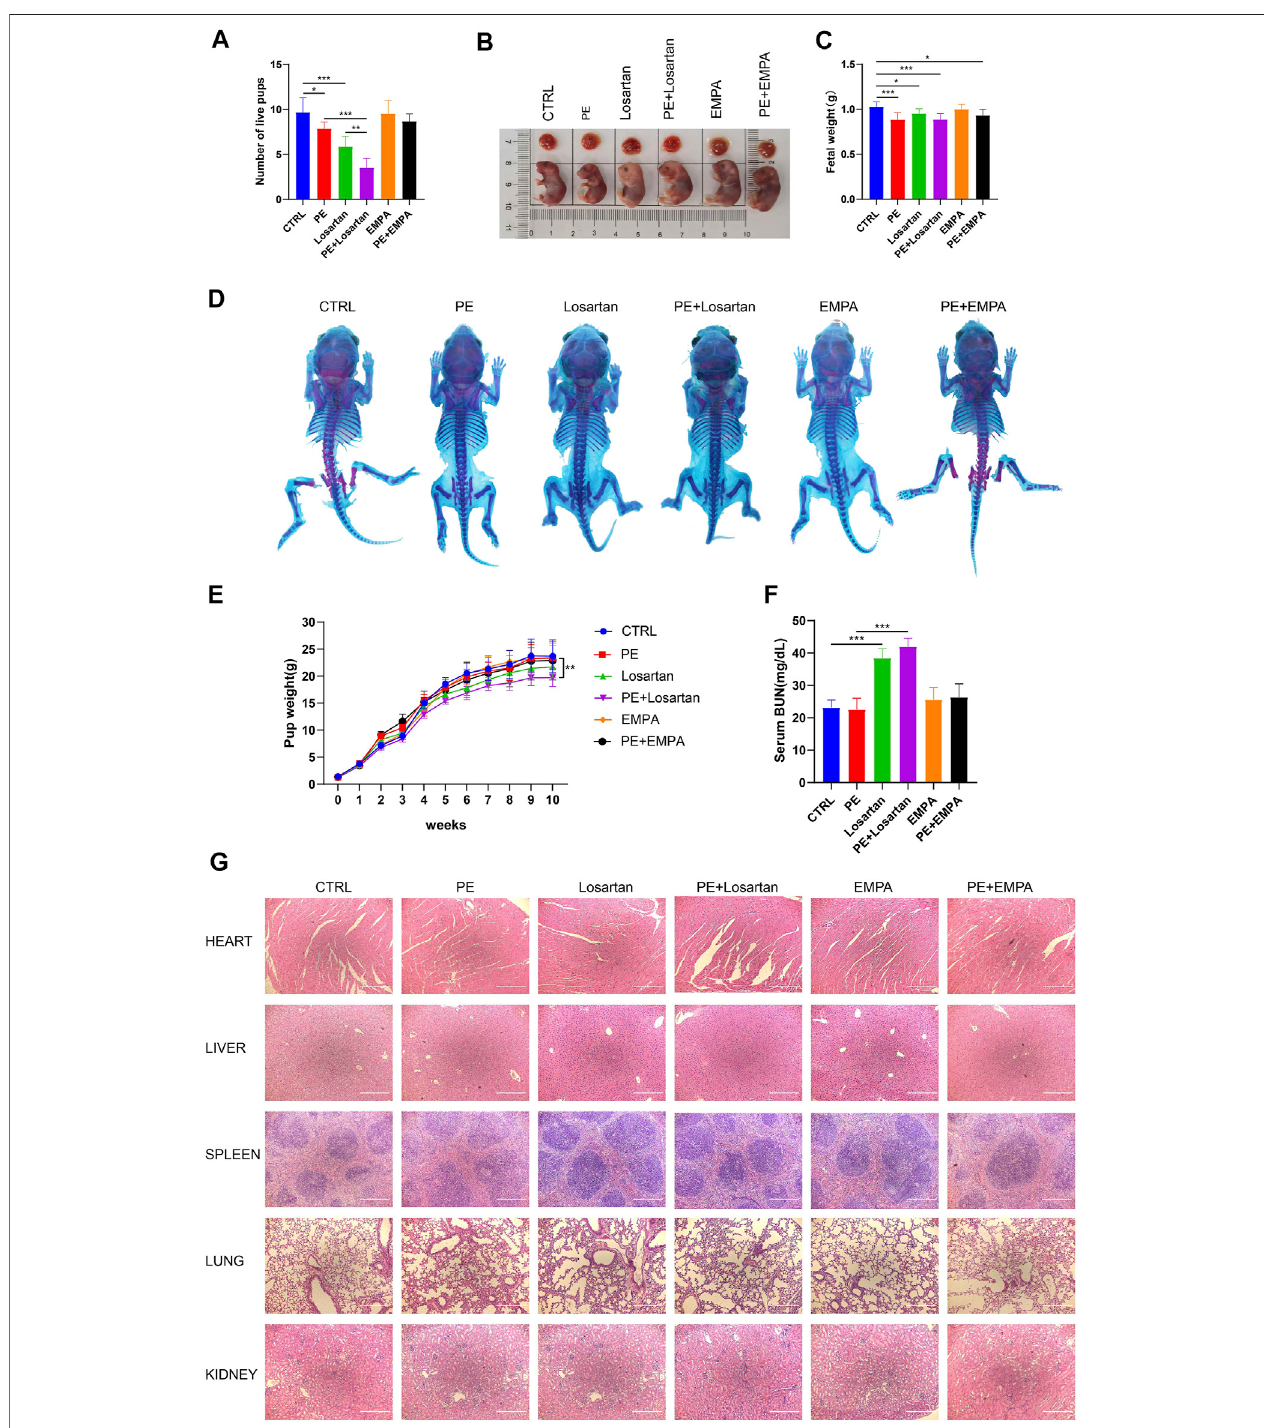
FIGURE 7 | Effects of EMPA on fetal outcomes in PE mice. (A) Histogram showing the number of live pups in each group ( n = 6). (B) Representative images showing the gross morphology of placentae (top) and embryos (bottom) in each group. (C) Histogram showing the fetal weight in each group ( n = 6). (D) Whole-mount alcian blue and alizarin red staining of 1-week-old offspring in each group. (E) Pup weights recorded from 0 to 10 weeks of each group ( n = 8). (F) Serum BUN levels of eachgroupofoffspringat10 weeksofage( n =6). (G) H&Estainingofhearts,livers,spleens,lungsandkidneysofoffspringmiceineachgroup.Scalebar:200 μ m. The results are expressed as the mean ± SEM. * p < 0.05, ** p < 0.01, *** p < 0.001.